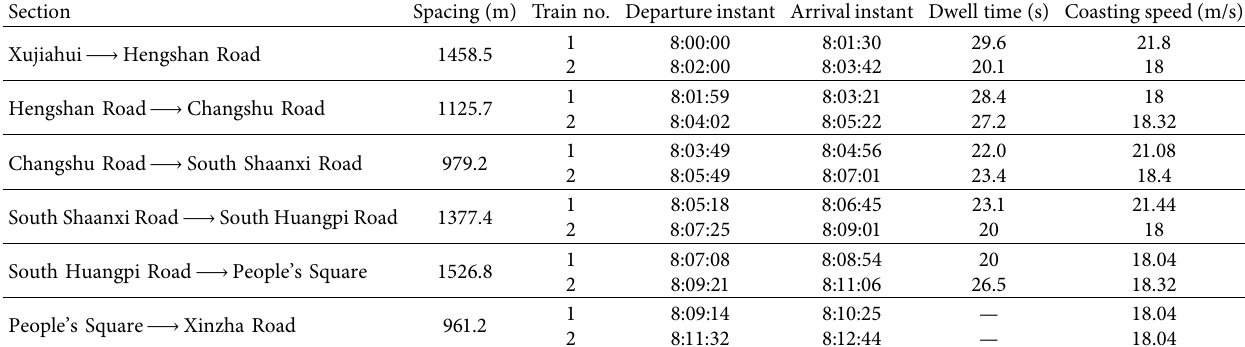
Table 3: The optimal timetable of the two-train system.